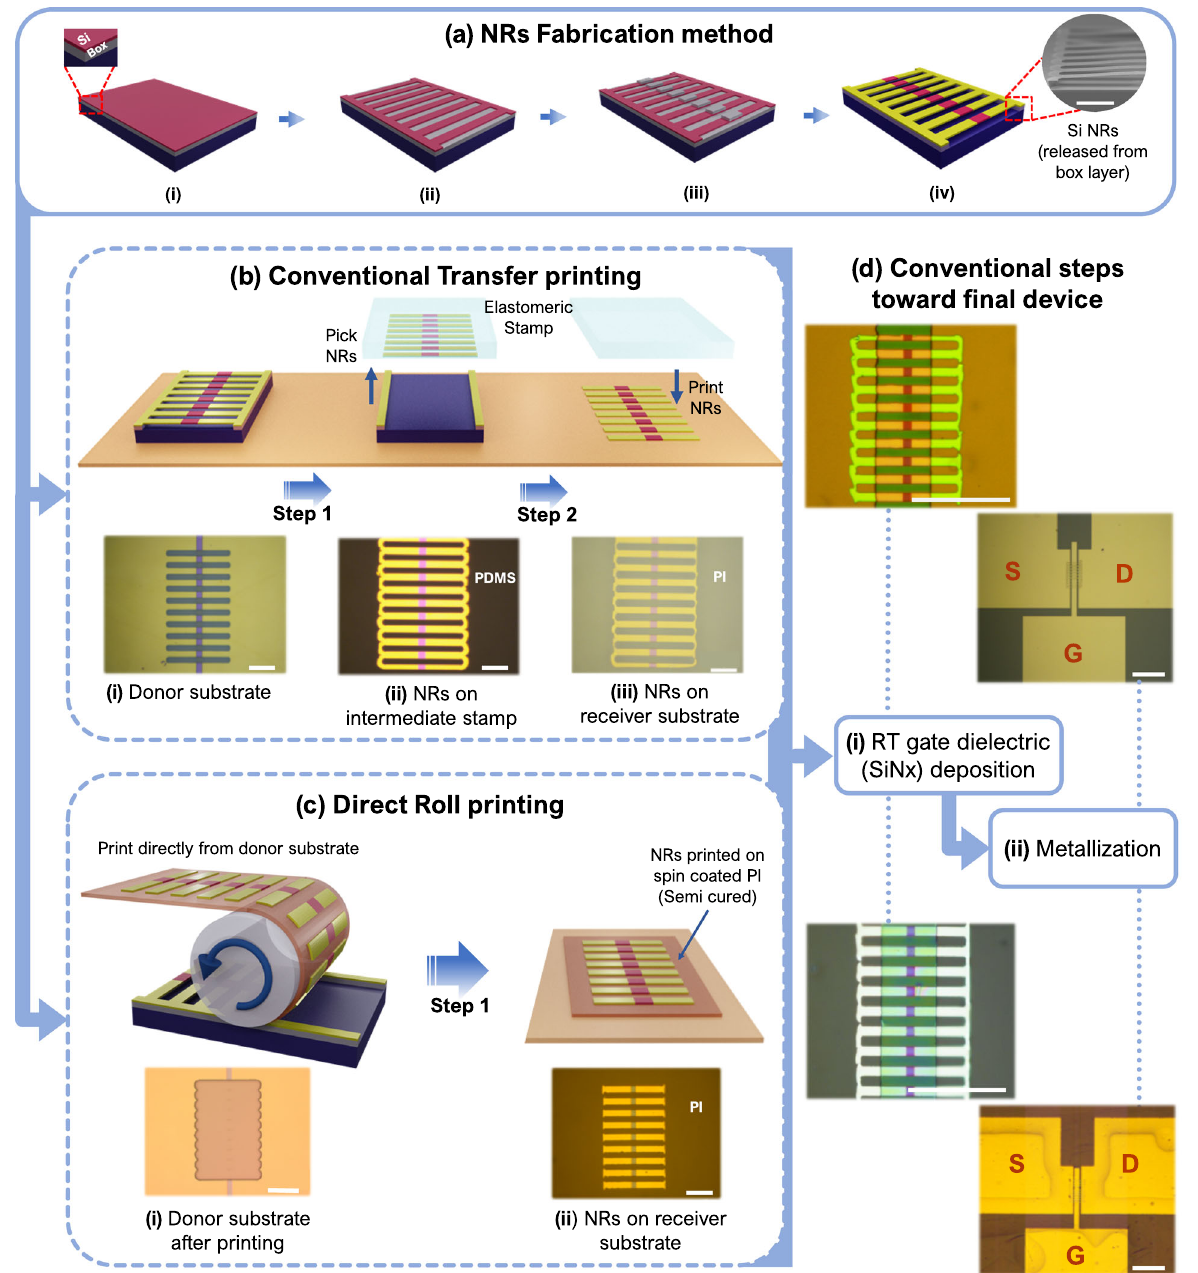
Fig. 1 Schematic illustration of the steps involved in the direct roll printing process with corresponding optical and SEM images. a Fabrication step of Si NRs carried out on the donor substrate with n + selective doping followed by releasing the NRs from buried oxide (Box) layer as shown in SEM cross-sectional image (scale bar, 10 μ m). b Conventional transfer printing steps using an elastomeric stamp (PDMS) with an optical image of each step (scale bar, 25 μ m). c Direct roll printing of NRs from donor to the semi-cured PI substrate (scale bar, 25 μ m). d